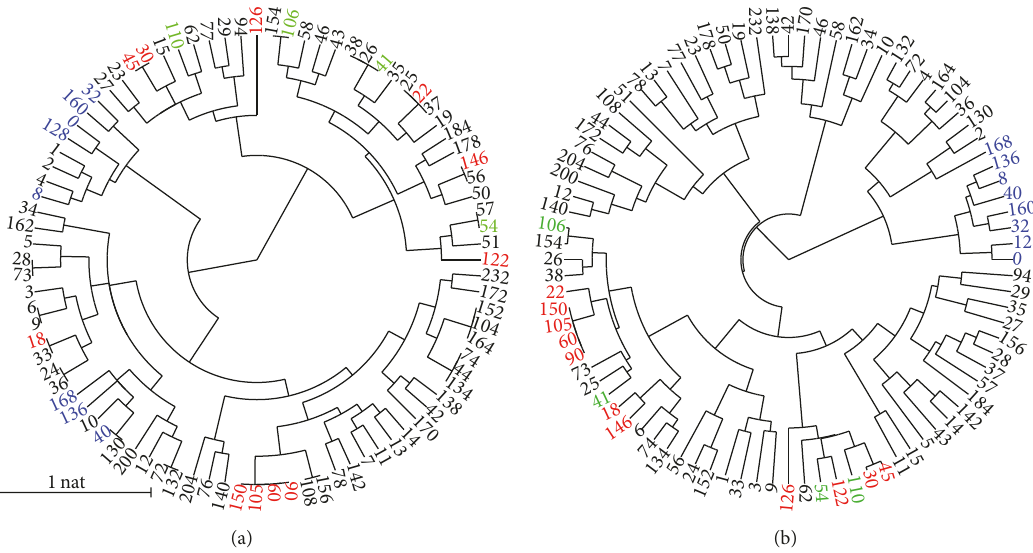
Figure 3: Dendrograms displaying two clusterings of information processing features: (a) the information measures are computed between time 𝑡 = 0 and 𝑡 = 1 , with no correlation between sites at time 𝑡 = 0 , and (b) when information processing features are evaluated numerically between time 𝑡 and 𝑡 + 1 once a steady state is reached. The color code is the same as in Figure 1 except that rules in class I are displayed in blue to distinguish them from class